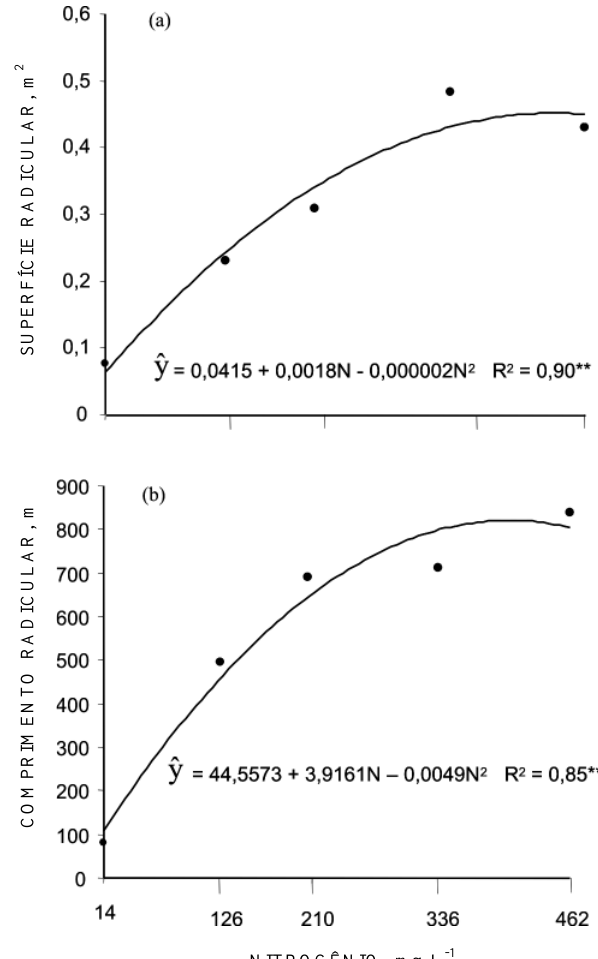
Figura 1. Superfície (a) e comprimento (b) do siste- ma radicular do capim-Marandu, considerando as doses de nitrogênio aos 79 dias do transplantio.